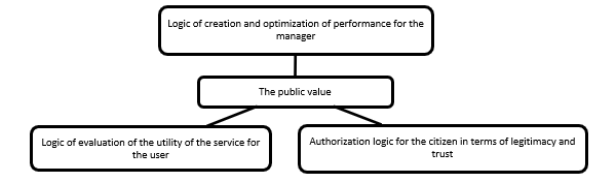
Figure 1. The triptych dimension of public value (source: authors’ conception based on the work of Horner & Hutton,